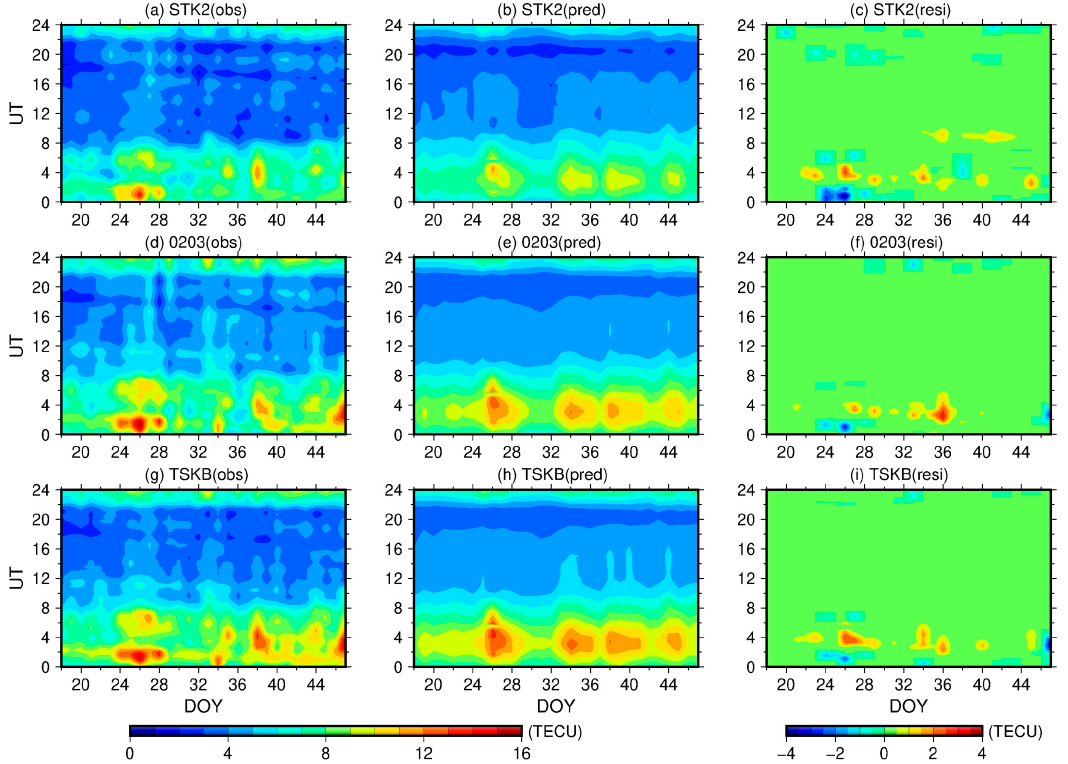
Figure 6. Comparative results between the daily variations of GNSS-TEC (left column) and JIM-TEC (middle column) over station STK2, 0203 and TSKB during DOY18-47, 2021. To further evaluate the spatial prediction performance of the JIM over the whole Ja- pan region, the TECs over 839 GNSS stations at UT06, UT12 and UT18 on 22 March 2021 were estimated by the GEONET observations. In addition, the TEC maps were also simu- lated by the JIM, GIM and IRI-2016 model, respectively. In the study, the GIM products were provided by the Center for Orbit Determination in Europe (CODE) via the link (http://ftp.aiub.unibe.ch/CODE/ (accessed on 15 March 2022). The accuracy of CODE-GIM was evaluated using observations from the Crustal Movement Observation Network of China (CMONOC), which is located at latitudes similar to those of Japan. The results in- dicate that the RMSE of CODE-GIM was about 2-4TECU under the magnetic quiet cir- cumstances, and for the magnetic disturbances circumstances, the RMSE increased to 5.7TECU [36]. The IRI-2016 model has demonstrated a high level of proficiency in predict- ing ionospheric variability and accurately depicting the spatial characteristics of global ionospheric convection, including the equatorial ionization anomaly (EIA), Weddell Sea anomaly and winter anomaly, among others. This assertion is supported by previous re- search [7,37]. For the purpose of this study, the observed solar-terrestrial indices of F10.7 and Dst were utilized as inputs for the IRI-2016 model to generate TEC maps. The F10.7 and Dst indices were obtained from GSFC (https://omniweb.gsfc.nasa.gov/form/dx1.html (accessed on 15 March 2022). The comparative results of three kinds of prediction maps are shown in Figure 7. Figure 7 shows distinct TEC latitudinal variations according to the amount of electron